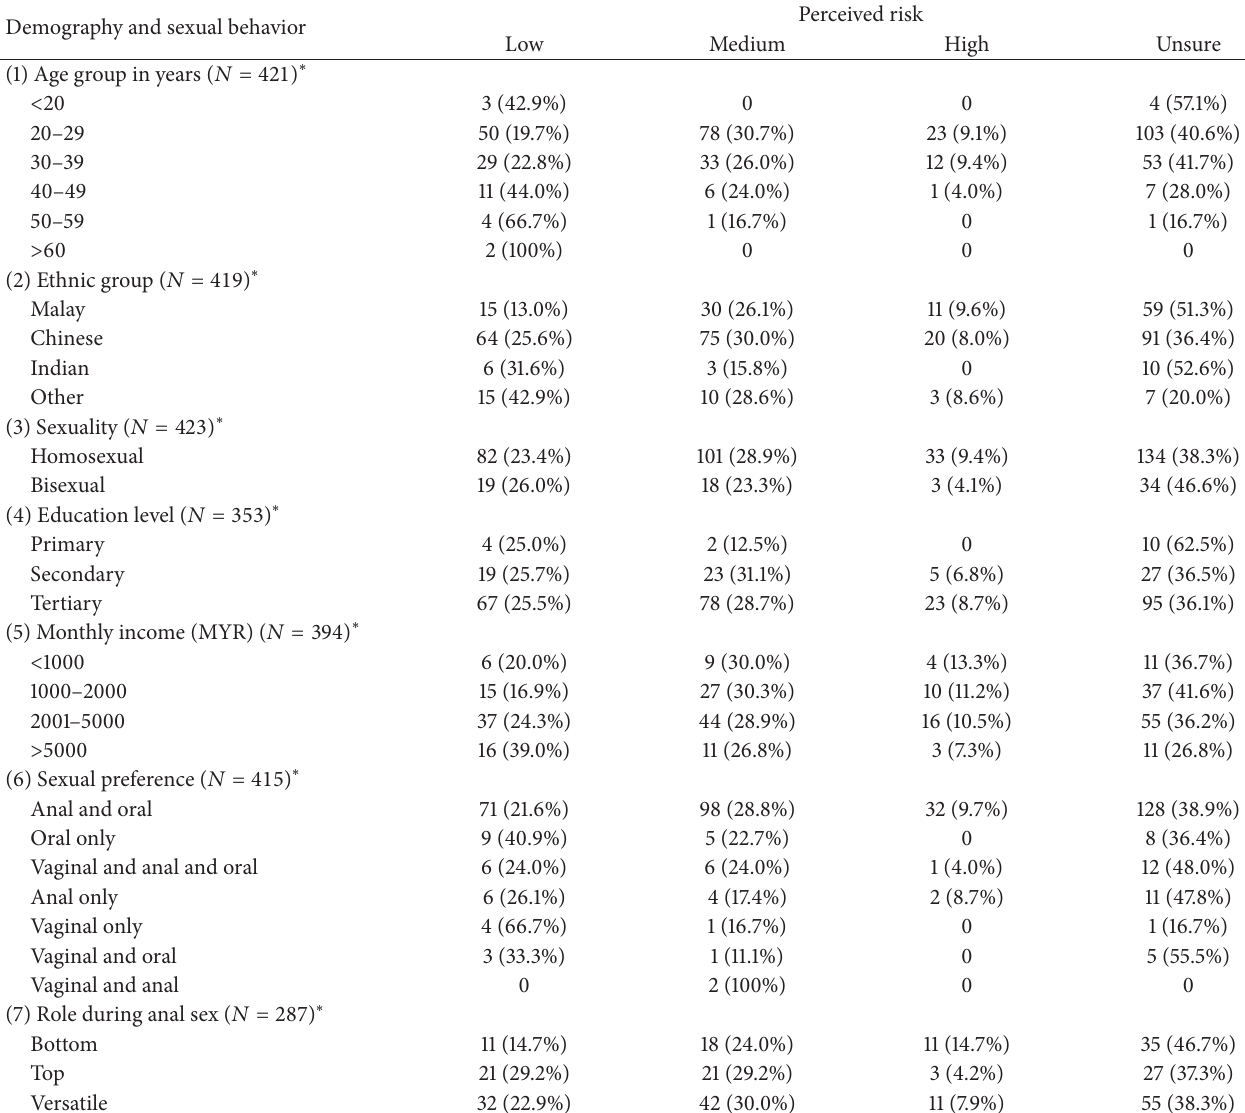
Table 1: Demographic characteristics and sexual behavior of MSM